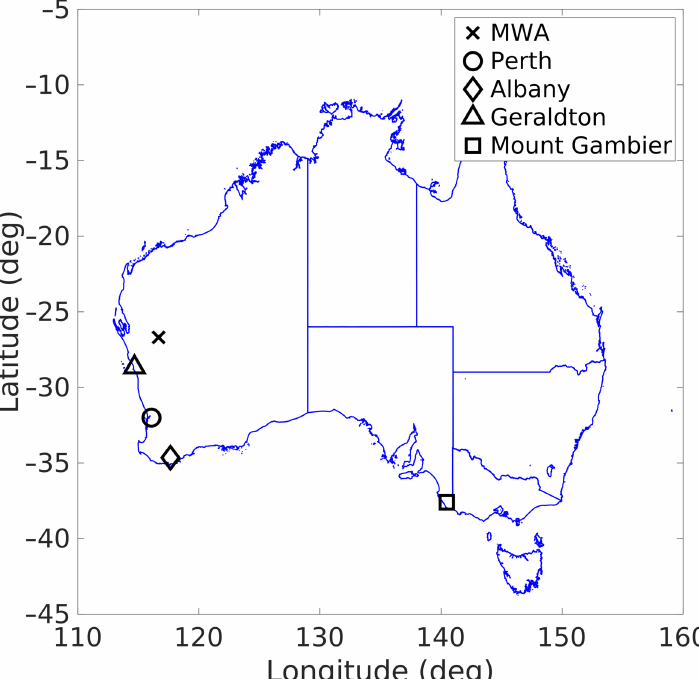
Figure 10. A map showing the Murchison Widefield Array as well as the transmitters used to generate the results in Section 6. Details of the transmitters are given in Table